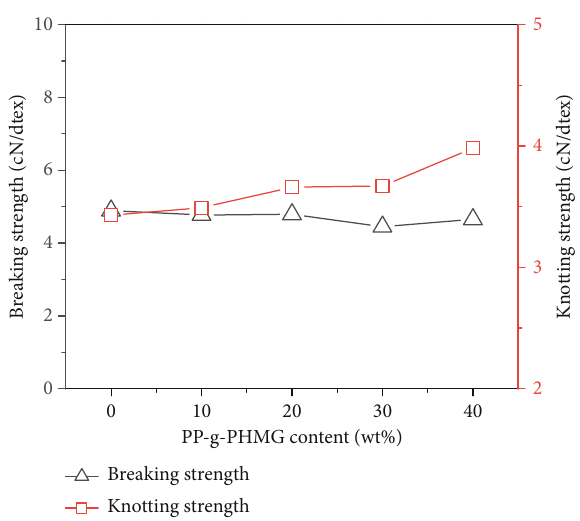
Figure 6: Dependence of the breaking strength and knotting strength of the PP-g-PHMG/PE alloy mono fi lament with di ff erent PP-g-PHMG